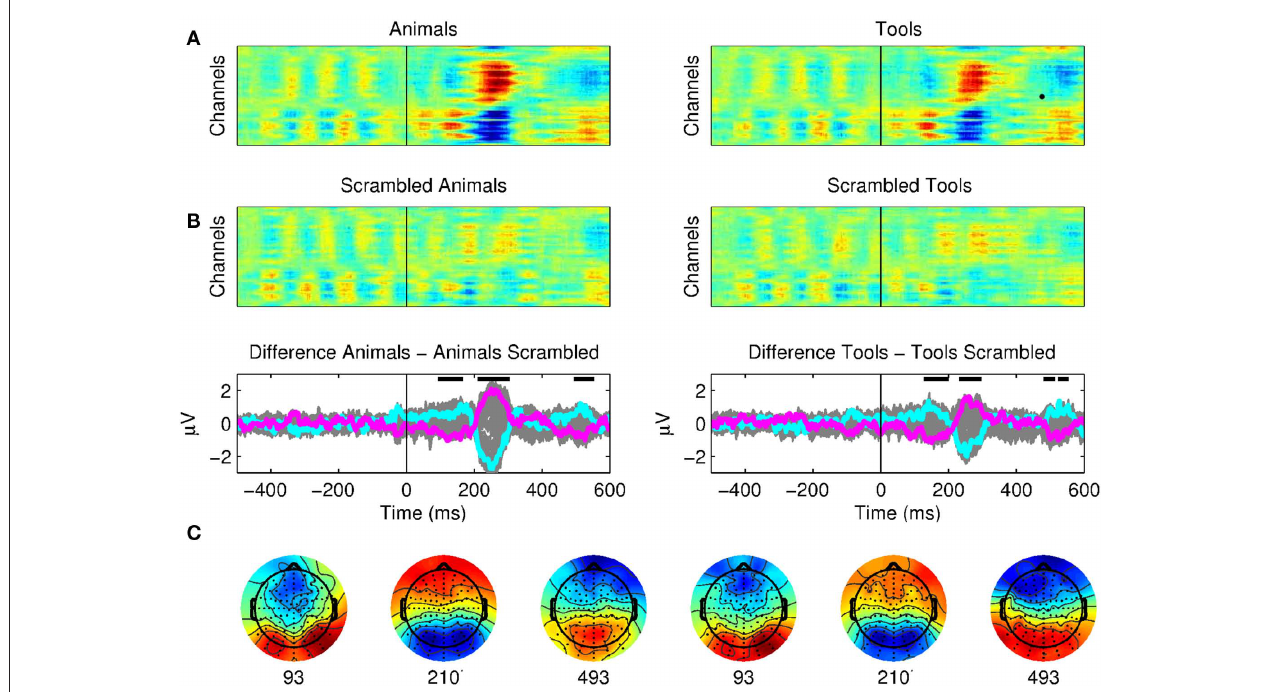
versus seen scrambled animals and seen tools versus seen scrambled tools are plotted for all channels (gray) and as particular examples for channel “OZ = cyan” and “FZ = magenta.” The activity of Mondrians is canceled by the subtraction between conditions. Upper dark bars indicate the time points where the signals showed statistical differences for both conditions (see Results). (C) Topographical maps show brain activity at the beginning of each period of